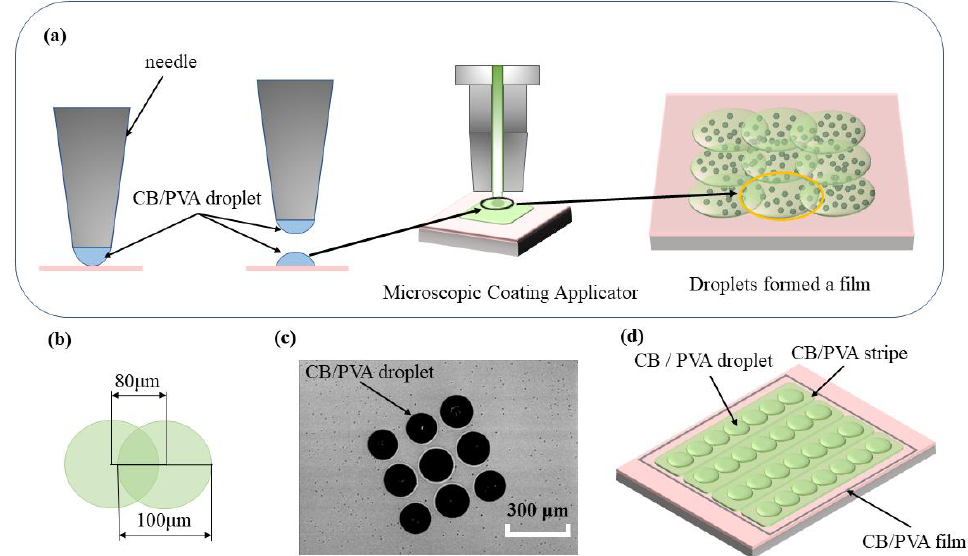
Figure 2. Schematic of film-forming mechanism of CB/PVA film. ( a ) Mechanism of droplets formation. ( b ) The distance between the centers of the droplets and the diameter of a droplet. ( c ) SEM image of deposed droplets. ( d ) The film formation by the droplet deposition method.